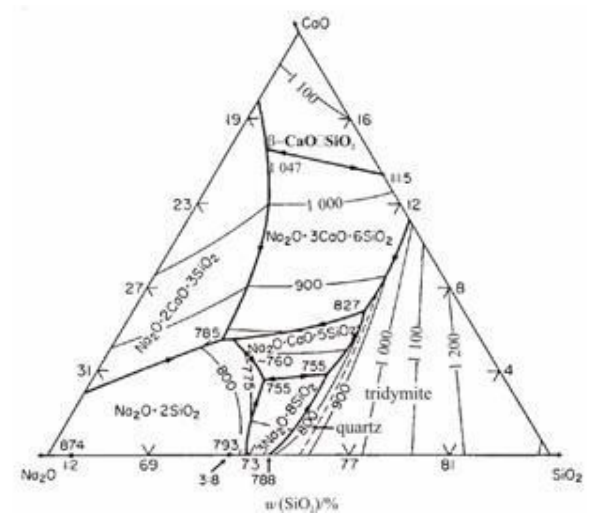
Figure 6. Diagram of the system Na 2 O-CaO-SiO 2 .